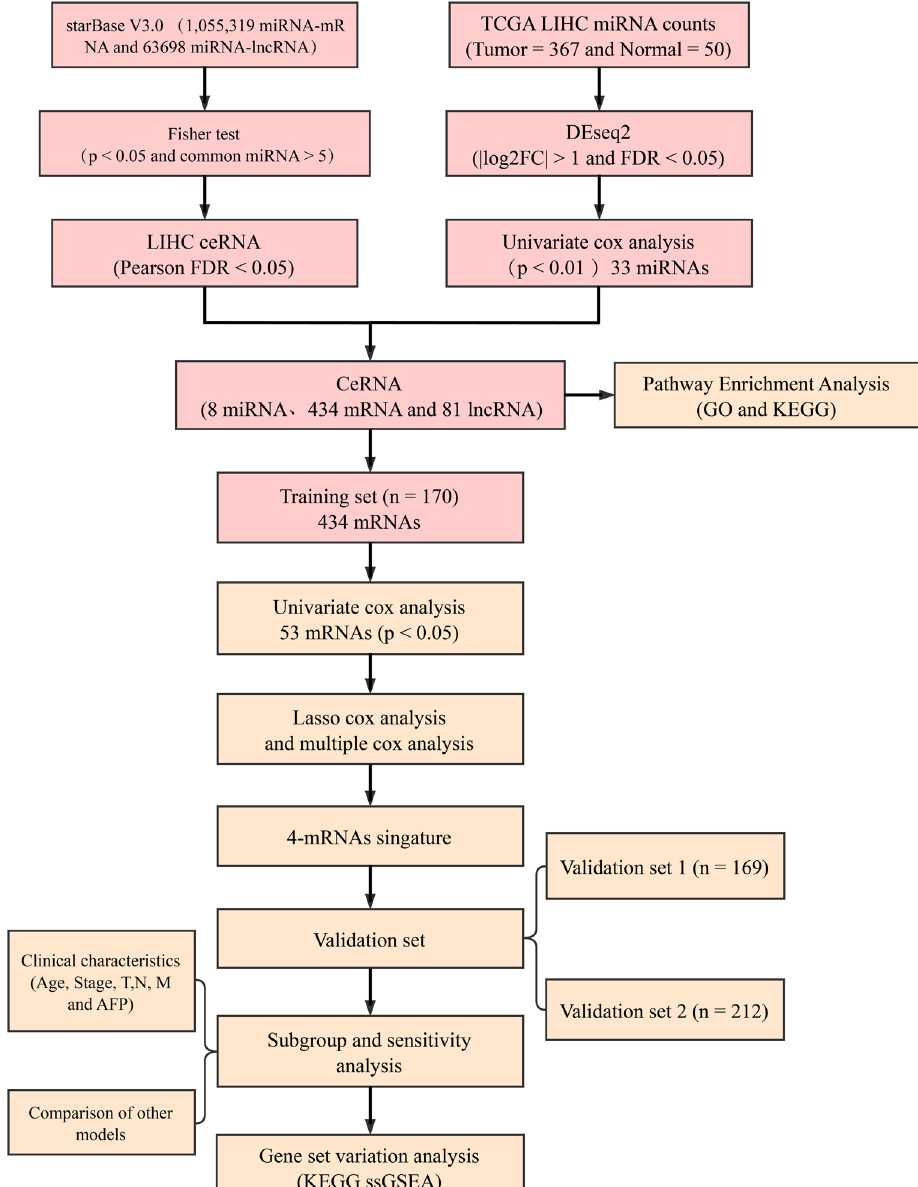
Figure 1: Work fl